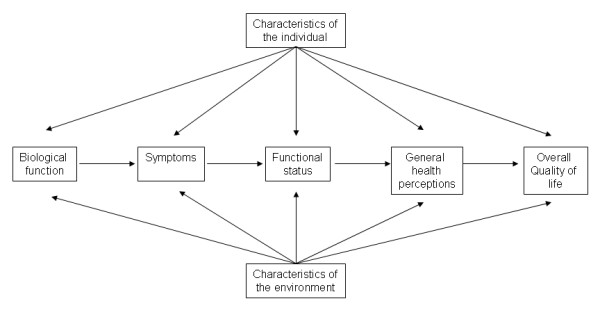
Revised Wilson and Cleary Model for Health-Related Quality of Life. Ferrans, C. E., Zerwic, J. J., Wilbur, J. E., & Larson, J. L. (2005). Conceptual model of health-related quality of life. Journal of Nursing Scholarship, 37, 336–342. Adapted from Wilson, I.B., & Cleary, P.D (1995). Linking Clinical Variables with Health-Related Quality of Life: A Conceptual Model of Patient Outcomes. JAMA. 273, 59–65. Copyright JAMA. Used with permissions.